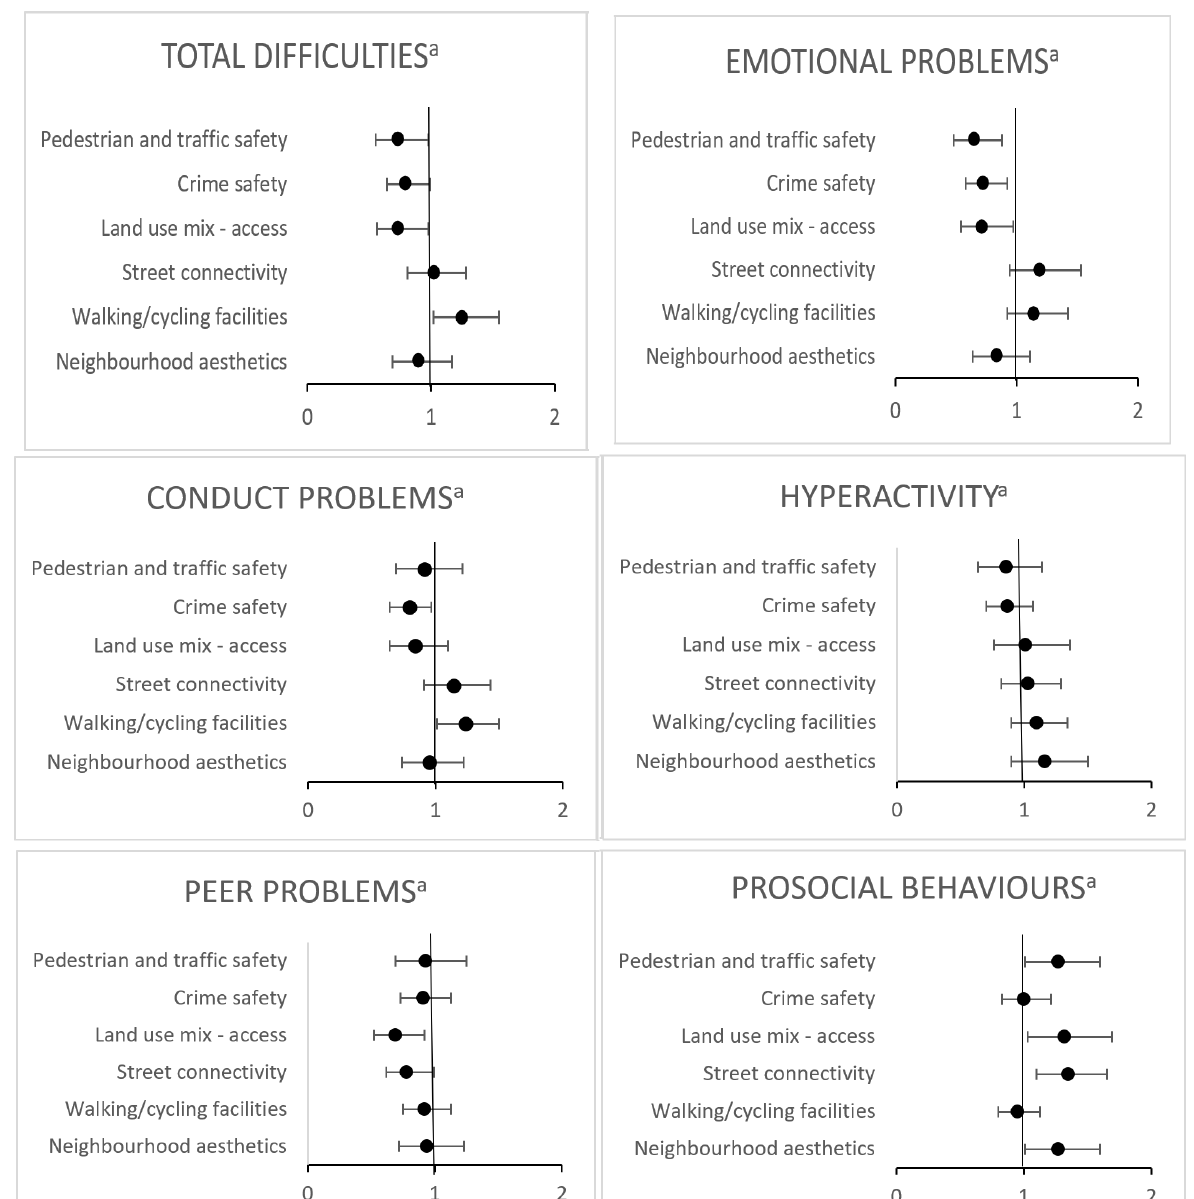
Figure 1. Forest plots showing odds ratios and confidence intervals of associations between parents’ perceptions of the neighbourhood built environment and social-emotional development. Statisti- cally significant at p  0.05; models adjusted for parent age, sex, education, employment status and child age, sex; neighbourhood disadvantage; residential self-selection and outdoor play. a Odds ratio of having an abnormal/borderline score representing poorer development. having an abnormal/borderline score representing poorer